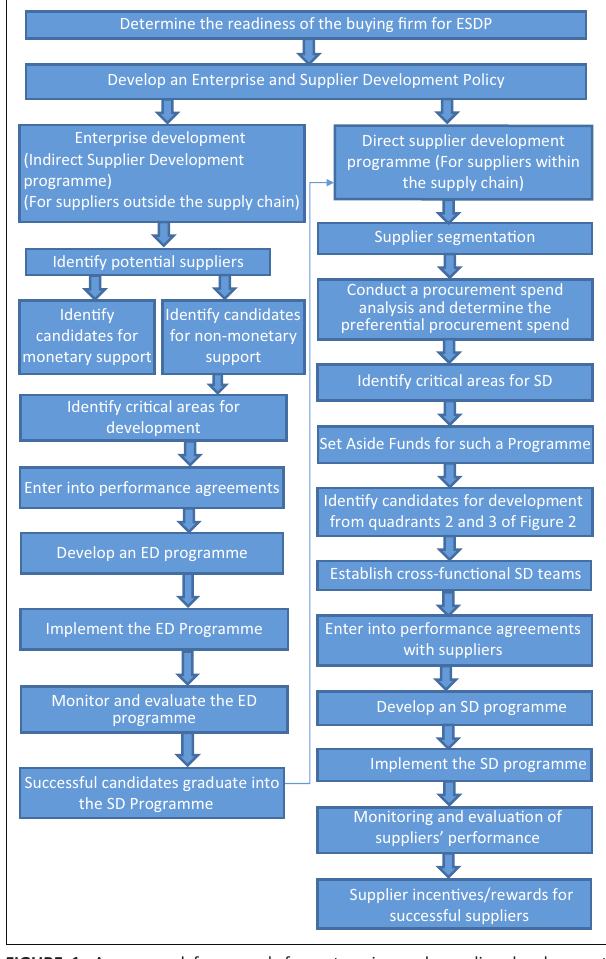
FIGURE 1: A proposed framework for enterprise and supplier development (ESD) programme.